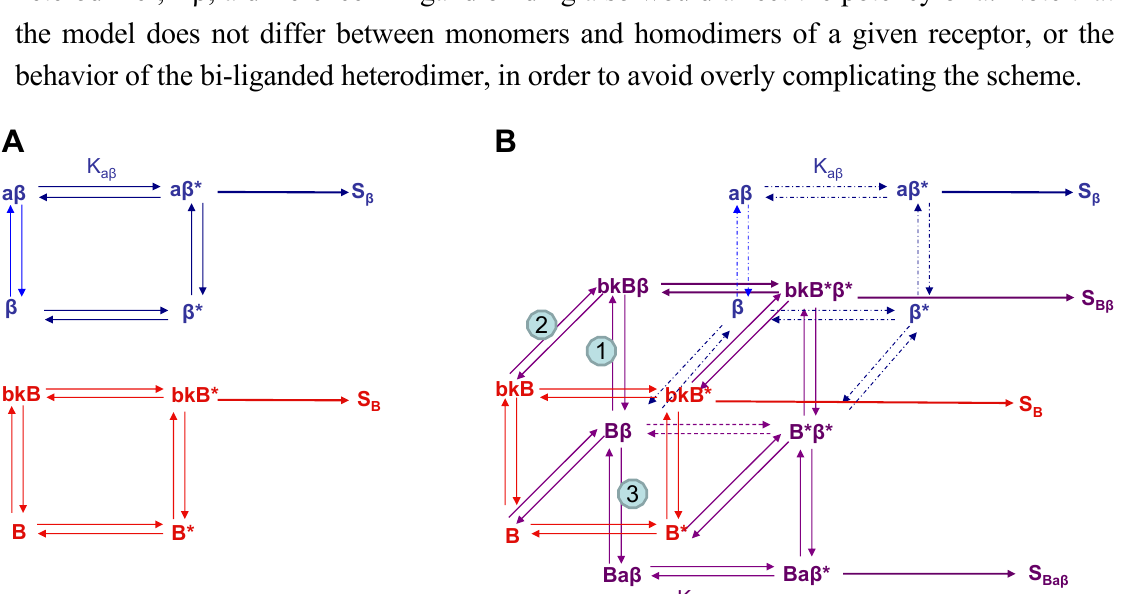
Figure 5. Allosteric model of GPCR heterodimerization, using as an example the interaction of β AR ( β , in blue) and B2R (B, in red); ligands are a (isoproterenol) and bk 2 (bradykinin). ( A ). Ternary complex models of both individual receptors; ( B ). The allosteric model of GPCR heterodimerization that includes both B2R, β AR, and B2R/ β AR 2 2 heterodimers. This model includes Bk2R binding bk, which in turn causes both B2R and β AR to adopt active conformations (bkB* β *), leading to activation of both G α q and G α s 2 signaling cascades and resulting in stimulus S . Binding of β AR agonist a in the presence B β 2 of B2R (Ba β *) only activates β AR, leading to stimulus S . In this scheme, we assume 2 BA β